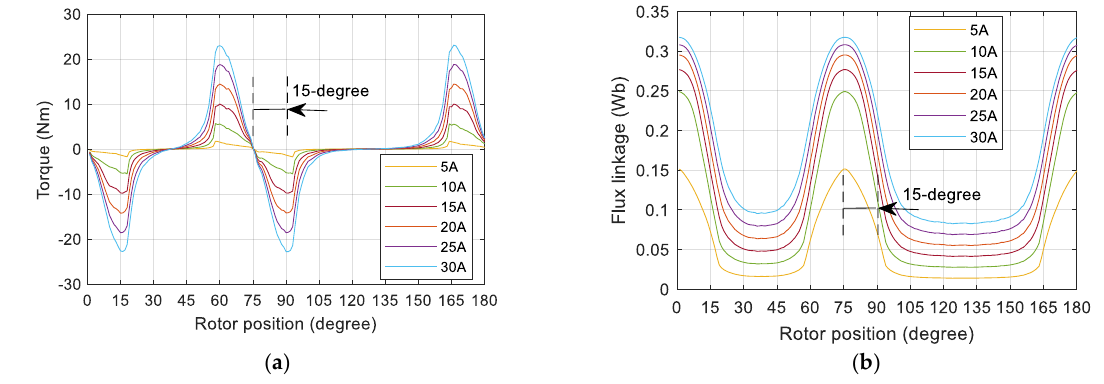
Figure 9. FEM simulation static torque and flux linkage profiles of the proposed SRM: ( a ) the static torque profiles; ( b ) the static flux linkage profiles.